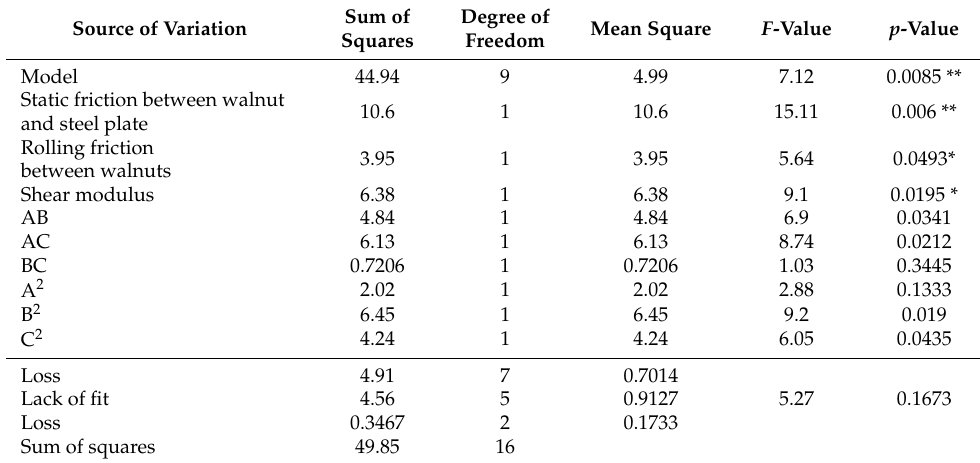
Table 8. The analysis of variance for the regression